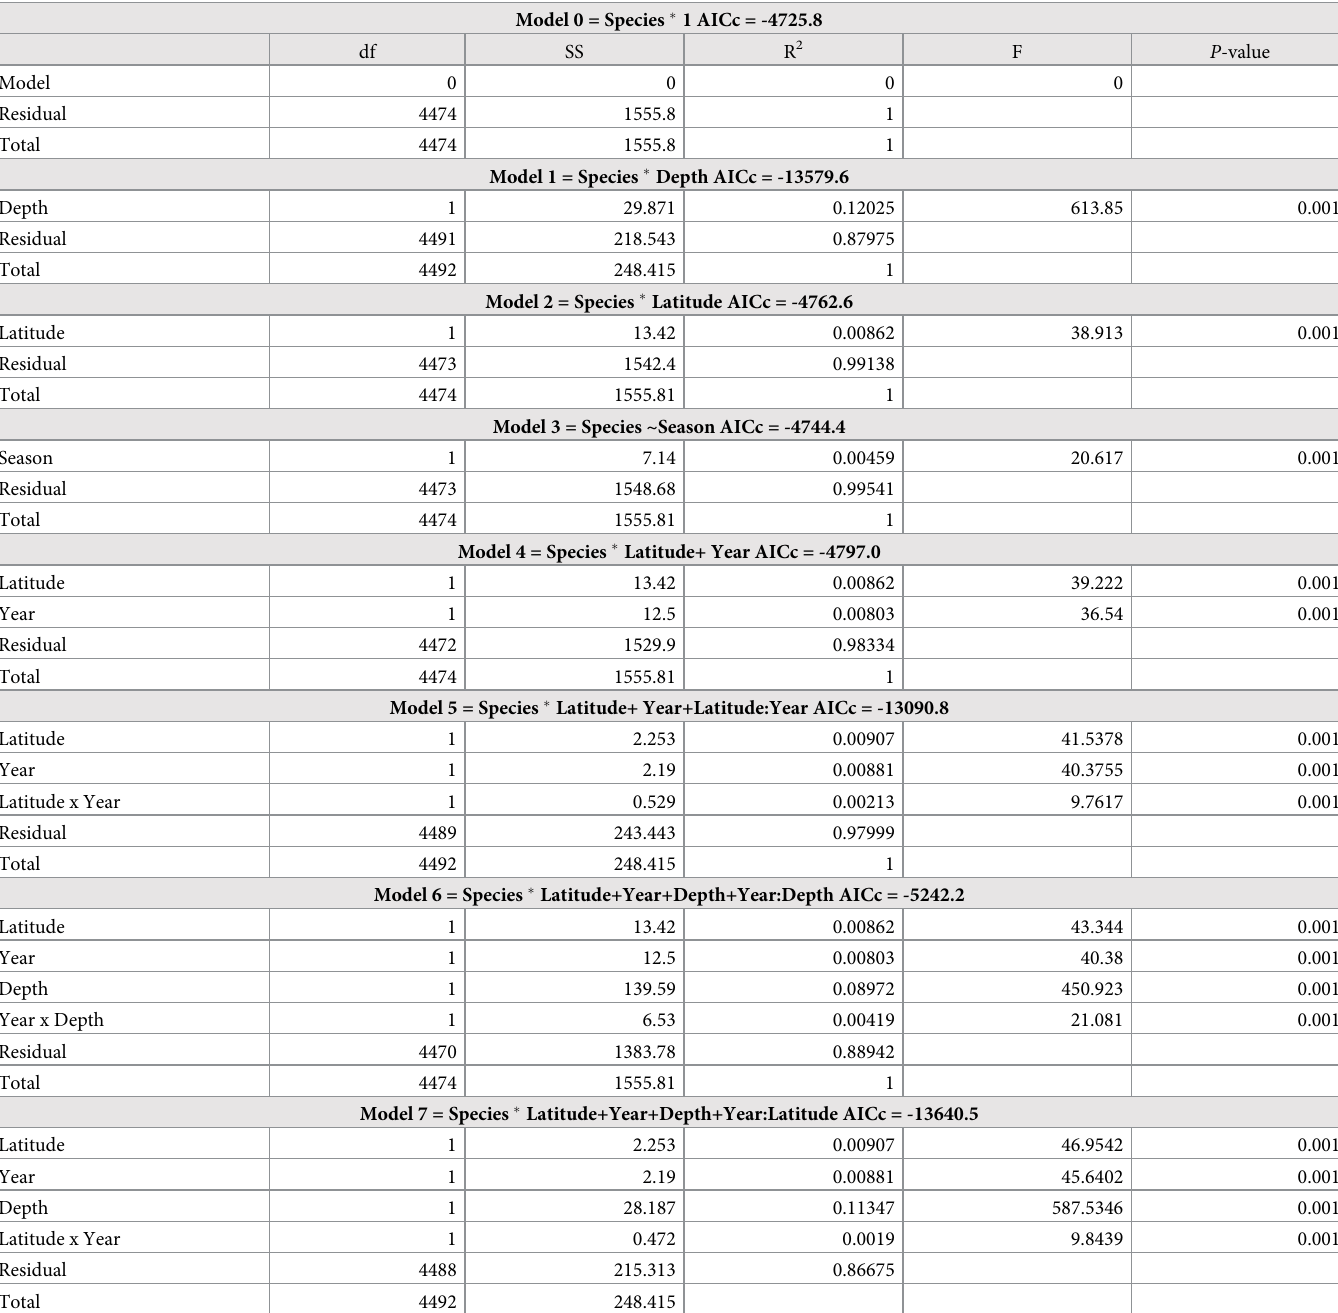
Table 4. PERMANOVA results showing the influence of all factors considered in the present study, zone, year, depth, and its interactions. Corrected Akaike Infor- mation Criterion (AICc) also is